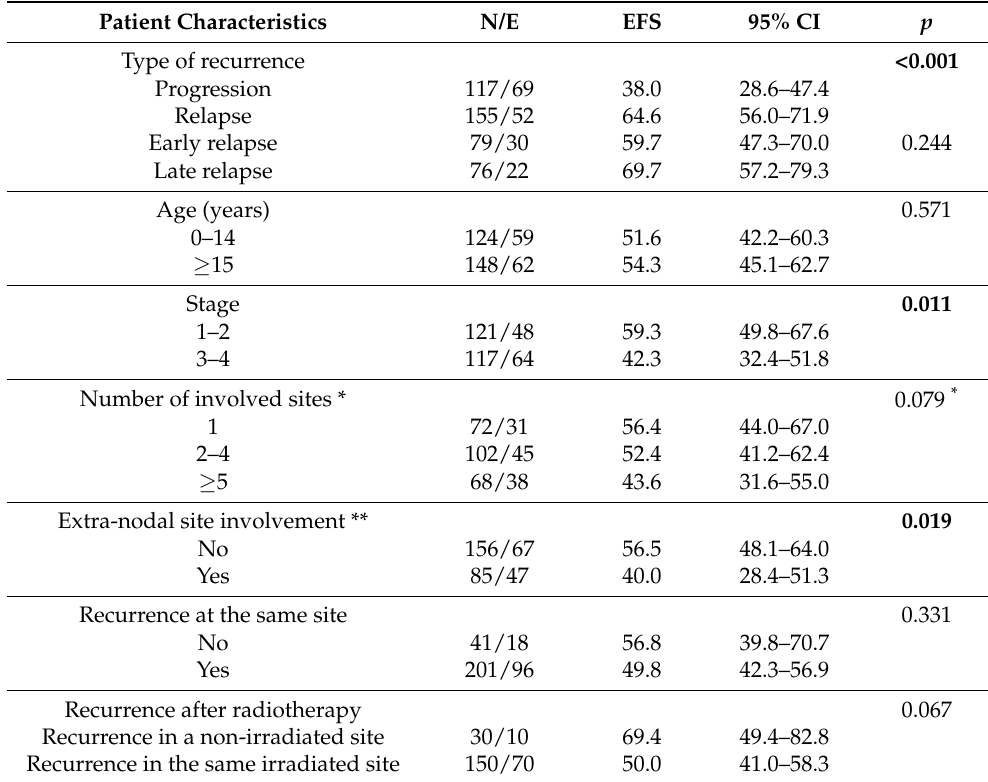
Table 7. Ten-year event-free survival of 272 patients with classical Hodgkin’s lymphoma after recurrence by characteristics at